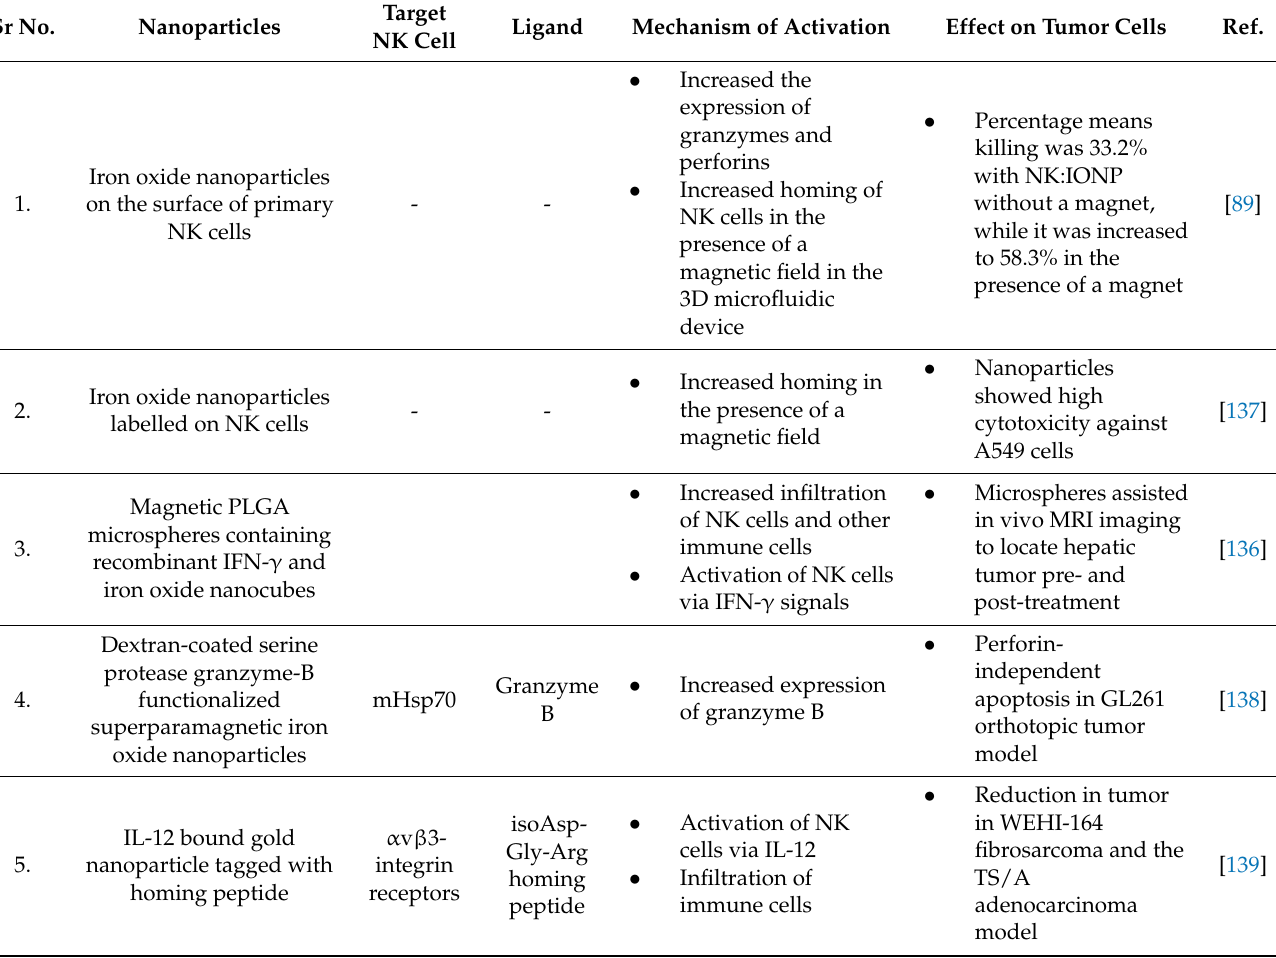
Table 3. Comprehensive information on nanoparticle assistance to enhance homing of NK